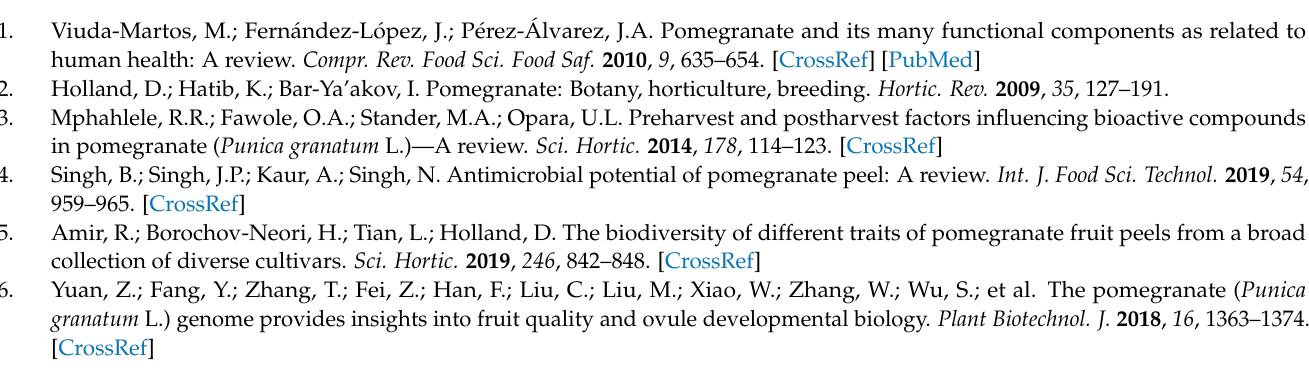
S2. DEG analysis; Table S3. List of all differentially expressed genes; Table S4. List of differentially expressed transcription factors; Table S5, list of genes involved in ABA metabolic pathway and signaling, Table S6, list of genes involved in ethylene and polyamines metabolic pathways and signaling, Table S7, list of genes involved in jasmonic acid metabolic pathway and signaling, Table S8, list of genes involved in gibberellic acids metabolic pathway and signaling, Table S9, list of genes involved in auxin metabolism and regulation, Table S10, list of genes involved in hydrolyzed tanins metabolic pathway, Table S11, list of genes involved in anthocyanins and flavonoids metabolic pathway and regulation, Table S12, list of genes involved in cutin and suberin biosynthesis, Table S13, list of genes involved in cell wall biosynthesis, Table S14, list of genes involved in lignin